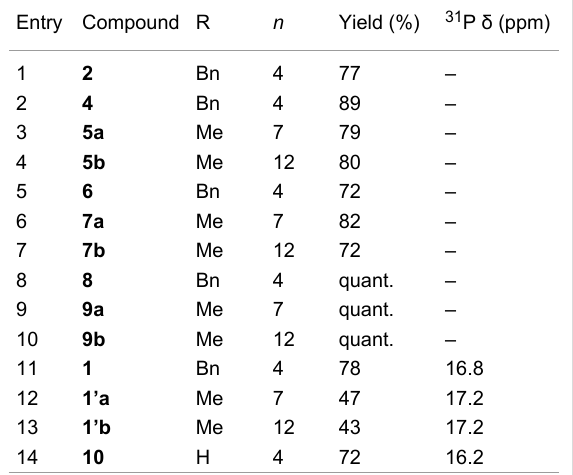
Table 1: Synthesis of PEG-HMBPs 1 , 1’ and 10